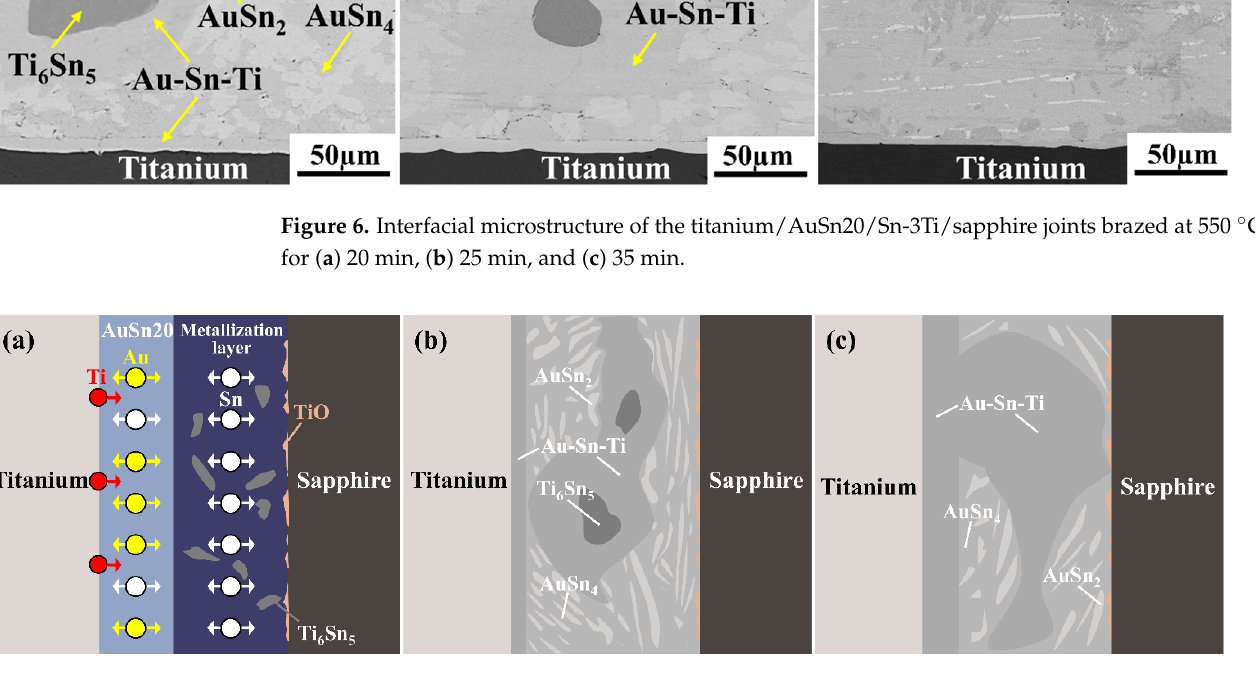
Figure 7. Schematic diagram of the microstructure evolution of titanium/AuSn20/Sn-3Ti/sapphire joint: ( a ) atomic diffusion; ( b ) formation of reaction products at 550 °C; and ( c ) interfacial structure of the brazing seam at 650 °C.